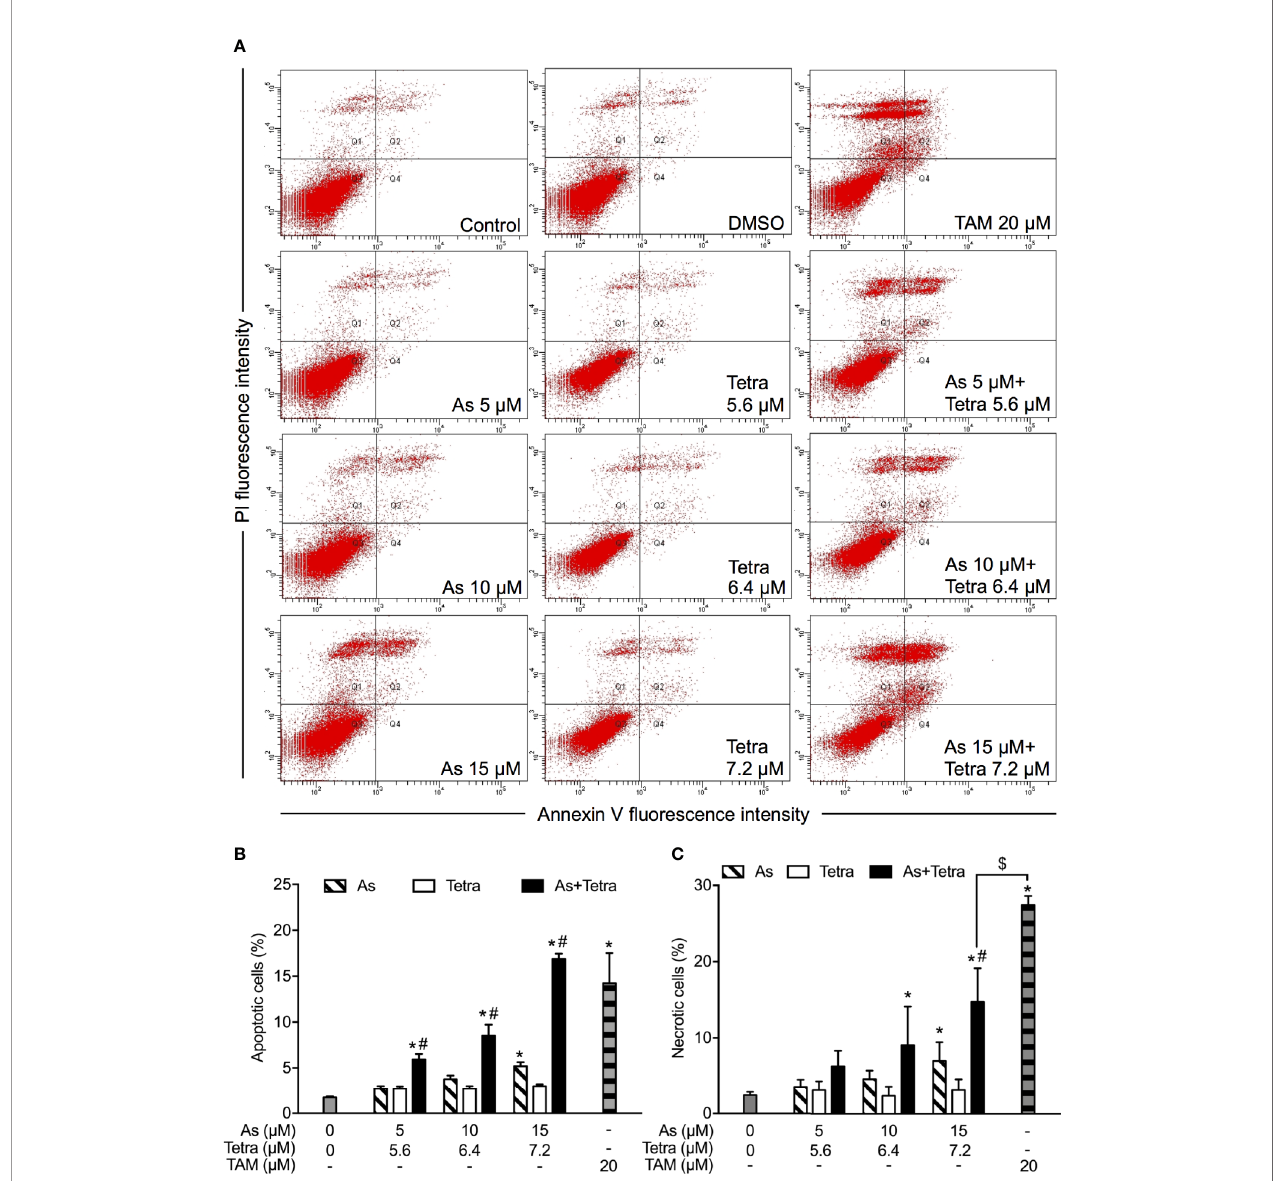
FIGURE 2 | Induction of apoptotic and necrotic cell death in MDA-MB-231 cells by As III combined with Tetra. (A) After treatment with indicated concentrations of As III and Tetra, alone or in combination, for 48 h, cells were stained with annexin V-FITC and PI, and analyzed by fl ow cytometry. Annexin V( − )PI( − ) cells, annexin V(+) PI( − ) cells, annexin V(+)PI(+) cells, and annexin V( − )PI(+) cell represent viable cells, early apoptotic cells, late apoptotic/necrotic cells, and necrotic cells, respectively. (A) Representative dot plots from three independent experiments are shown. Quanti fi cations in the percentages of apoptotic cells (B) and necrotic cells (C) are shown, respectively. *p<0.05 vs. control; # p<0.05 vs. each alone; $ p<0.01 vs. TAM. TAM (20 µM) used as an inducer (positive control) for the induction of apoptosis and necrosis. As, As III ; Tetra, tetrandrine; TAM,